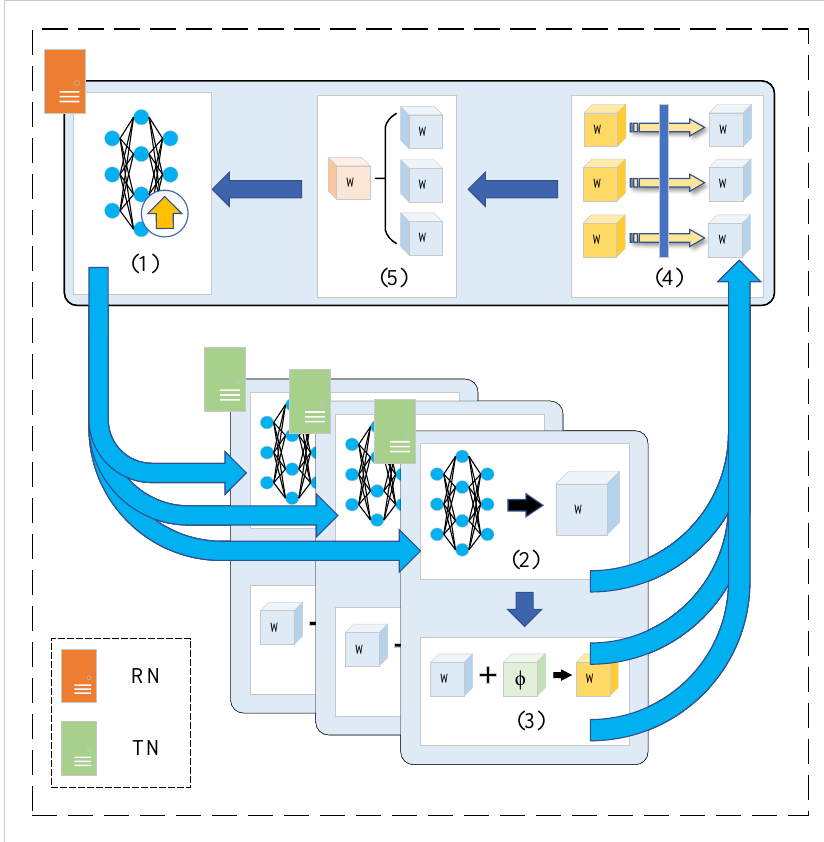
Figure 1. The workflow of